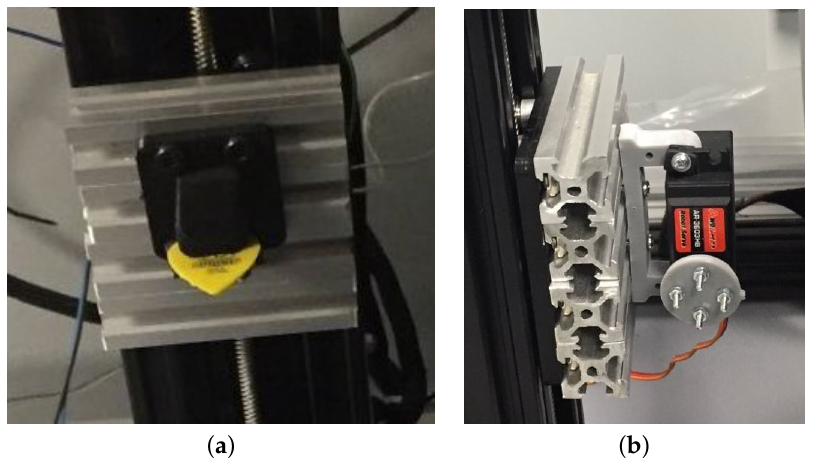
Figure 1. Test stand used in the research.